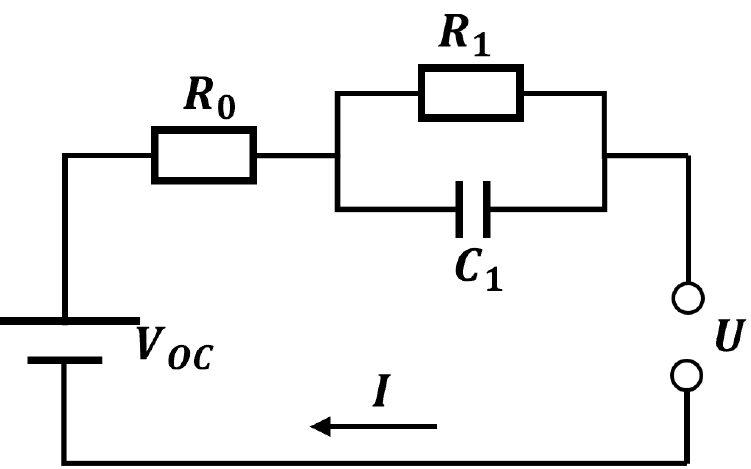
Figure 5. First-order equivalent circuit model of a lithium-ion battery.